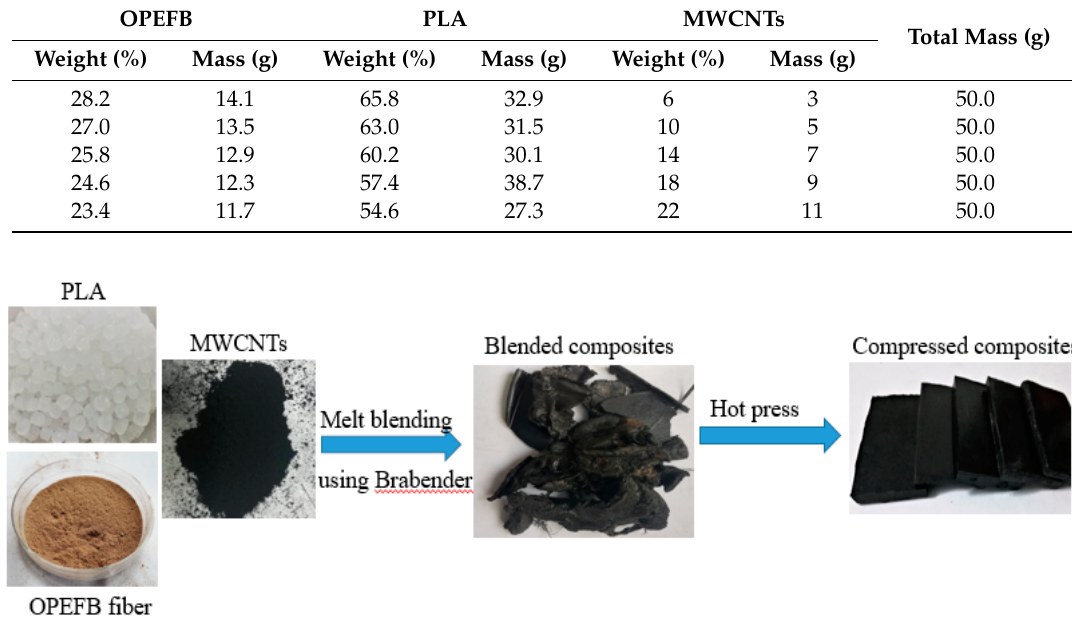
Figure 1. Fabrication of OPEFB/PLA/MWCNTs composites.